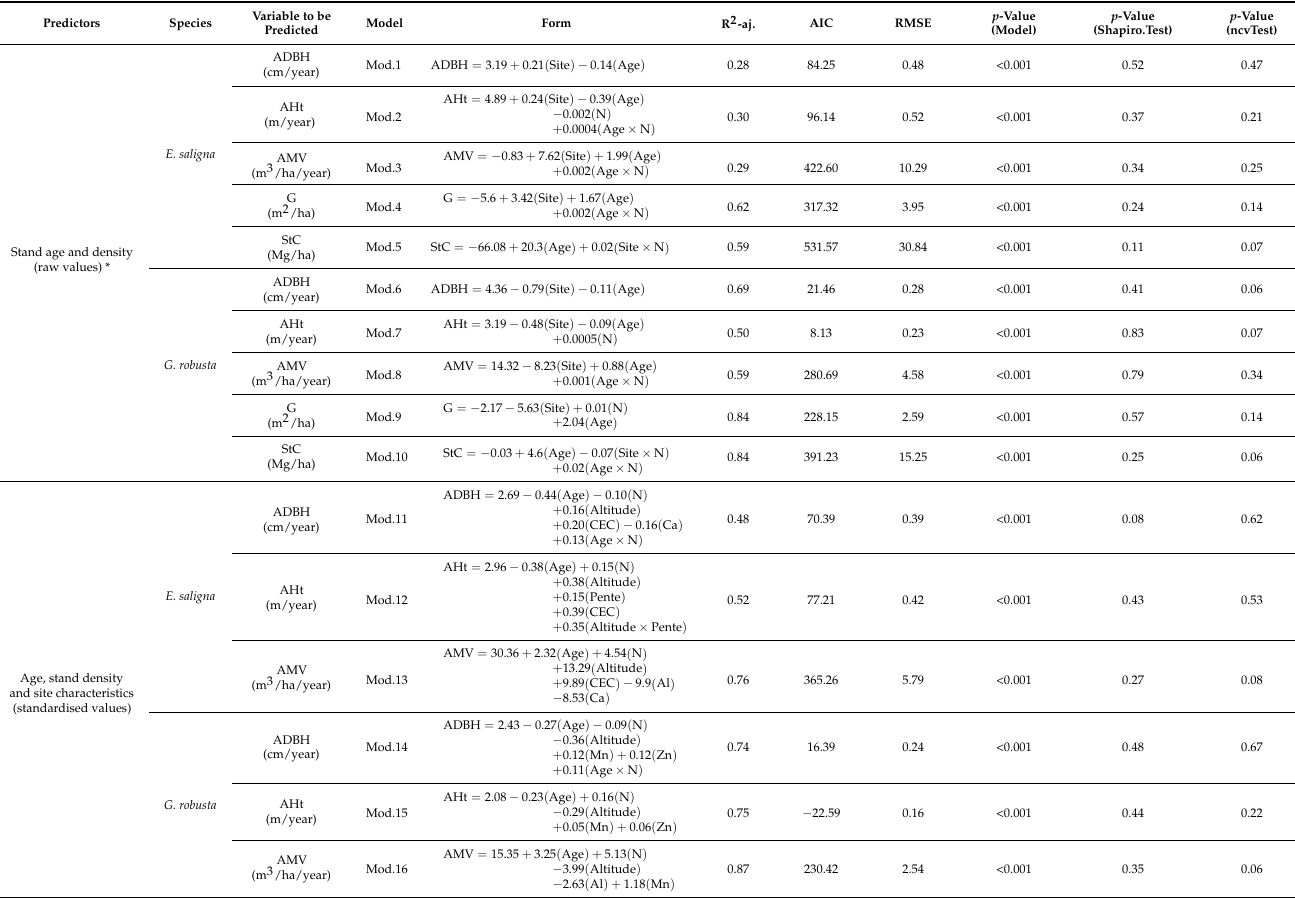
Table 3. Presentation of the models used for increments, basal area and carbon stock. ADBH: average increment in diameter; AHt: average increment in total height; AMV: average increment in volume; G: basal area; StC: carbon stock; R 2 -aj: adjusted coefficient of determination; AIC: Akaike’s information criterion; RMSE: root mean square error; N: stand density; CEC: cation exchange capacity; Al, Ca, Mn, Zn: respectively, the concentration of aluminium, calcium, manganese and zinc in the soil; Mod: model. The site codes are ‘1’ for Sake and ‘2’ for